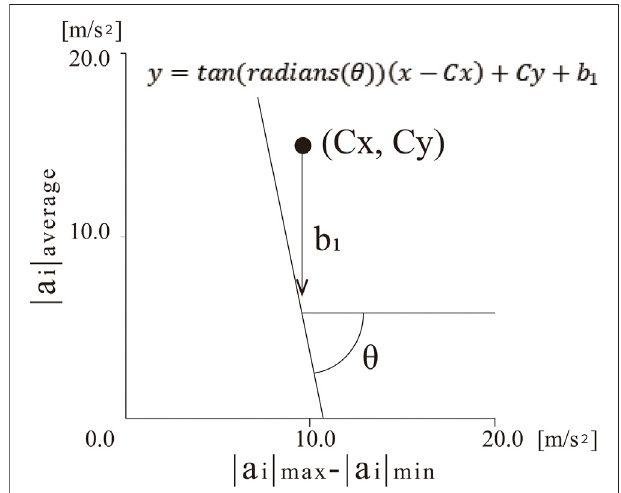
FIGURE 4 | The function of